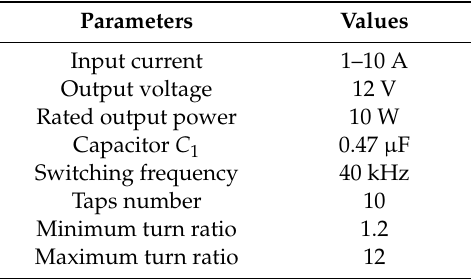
Table 1. Parameters of the prototype.